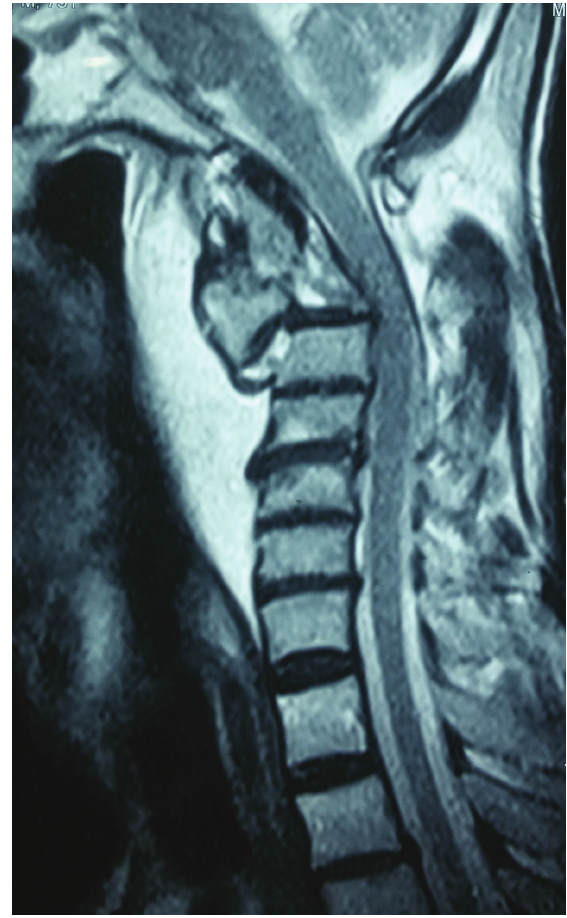
Figure 2. MRI (t2 sequence) of the cervical spine revealing presence of pinching effect but no signal changes in the